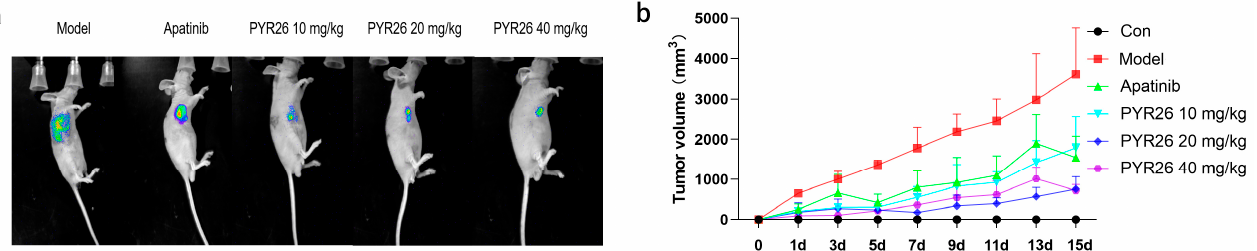
Figure 7. Tumor volume size after drug administration in nude mice. ( a ) Nude mice were given different concentrations of drug 14 d later. ( b ) Curves of tumor volume change at 14 d in nude mice with blank, model, positive control, low PYR26, medium PYR26 and high PYR26.